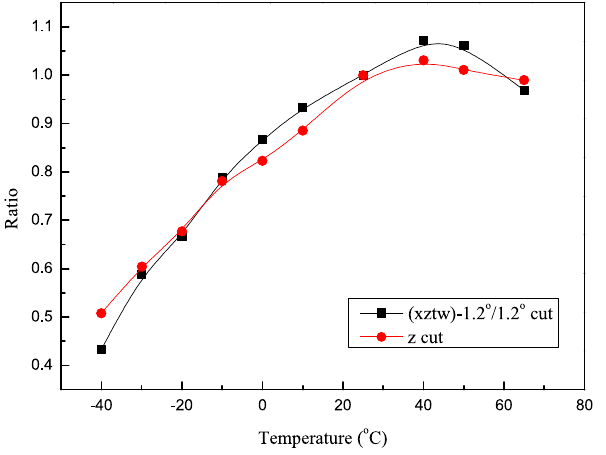
Figure 5. The ratios of output energy at every temperature to that at room temperature versus